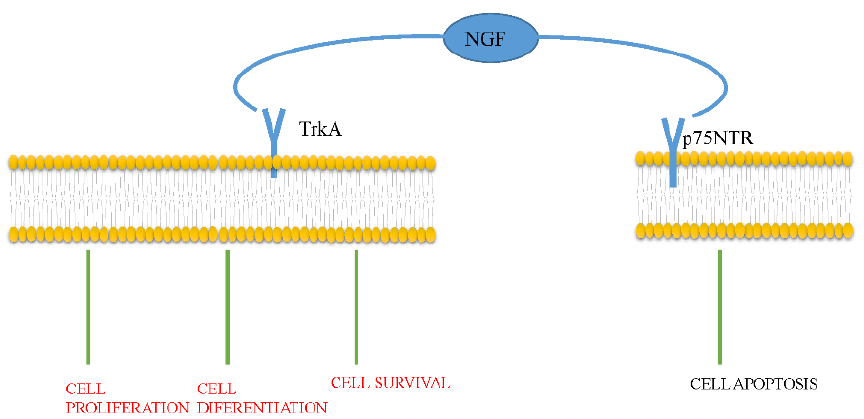
Figure 1. NGF exerts its function by activating TrkA and p75NTR. Activation of TrkA induces differ- entiation, proliferation, and survival of the target cell, while p75NTR activation induces apoptosis.